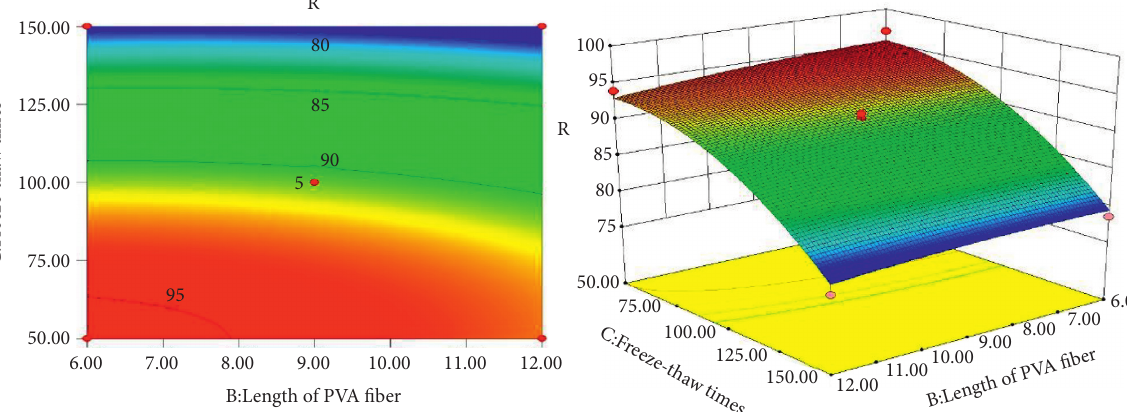
Figure 6: The effect of the interaction of B and C on R.